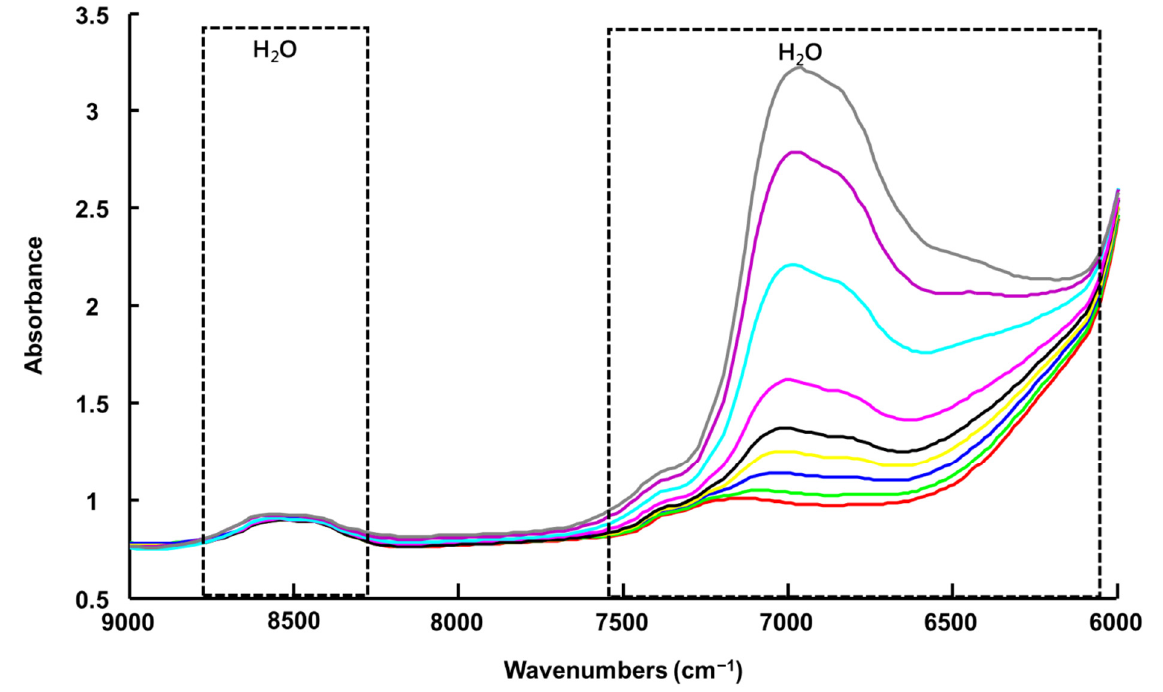
Figure 6. Mean raw NIR-H spectra collected from LALP. Concentrations for added water (% w / w ) are respectively ~ 0% (red), 0.99% (green), 2.4% (blue), 4.7% (yellow), 6.9% (black), 9.1% (magenta), 16.7% (cyan), 23% (purple) and 28% (grey).